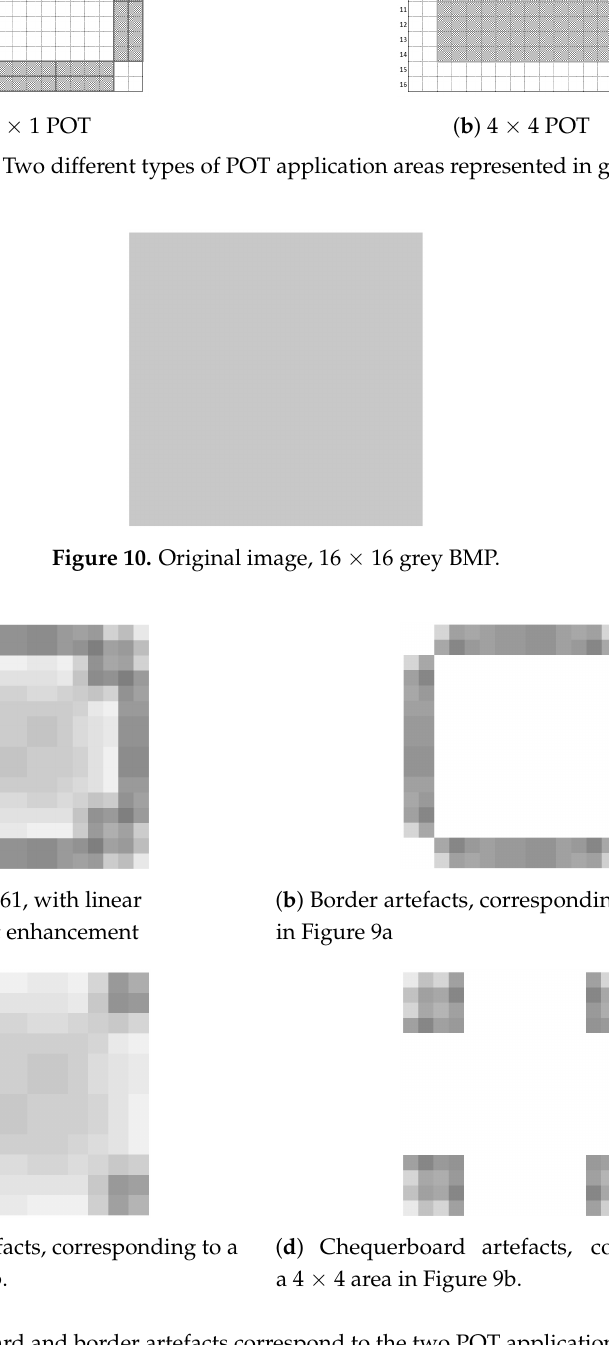
Figure 11. Chequerboard and border artefacts correspond to the two POT application areas, while the corner artefacts correspond to the four missing corners where POT was not